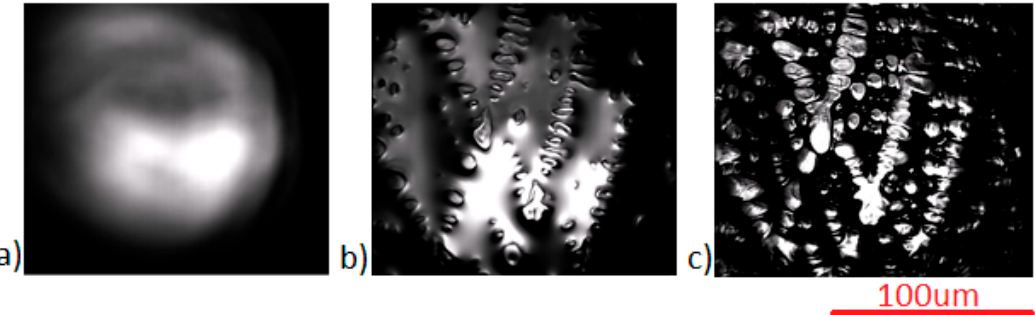
Figure 4. Images from the CSLM during cooling in Ar, taken at ( a ) 5 s (liquid steel), ( b ) 23 s (partial solidification) and ( c ) 30 s (fully solidified) according to Figure 3.